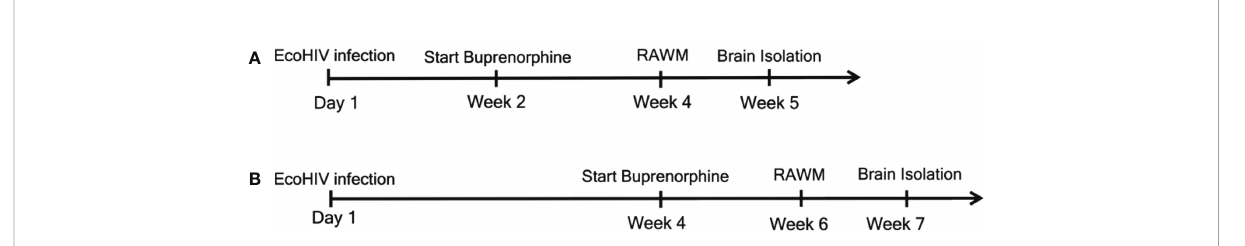
FIGURE 1 Experimental outline for the two treatment timepoints. We began daily buprenorphine injections at two different timepoints. For (A) mice were infected with EcoHIV at Day 1. Buprenorphine injections started two weeks later and were administered daily for the remainder of the experiments. After the additional two weeks, for a total of four weeks, mice underwent RAWM testing to assess cognitive status. RAWM testing was for one week, after which brains were isolated for monocytes, HIV DNA, and synaptodendritic pruning studies. For (B) , mice were infected and daily buprenorphine injections began four weeks later and continued for the remainder of the experiments. At week six, mice were assessed for cognitive impairment using the RAWM, and at week seven brains were isolated for monocyte and virological